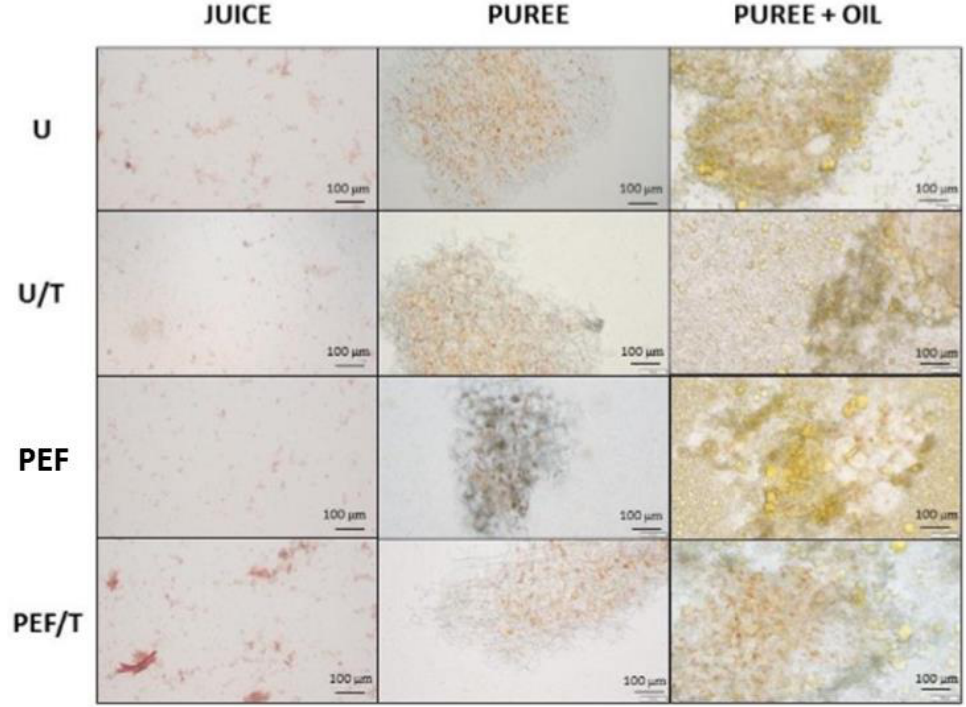
Figure 1. Representative light micrographs of juices and purees obtained from untreated carrots (U), obtained from PEF-treated (0.61 kJ kg − 1 ) carrots (PEF) and thermally treated (10 min at 70 °C) (U/T and PEF/T).